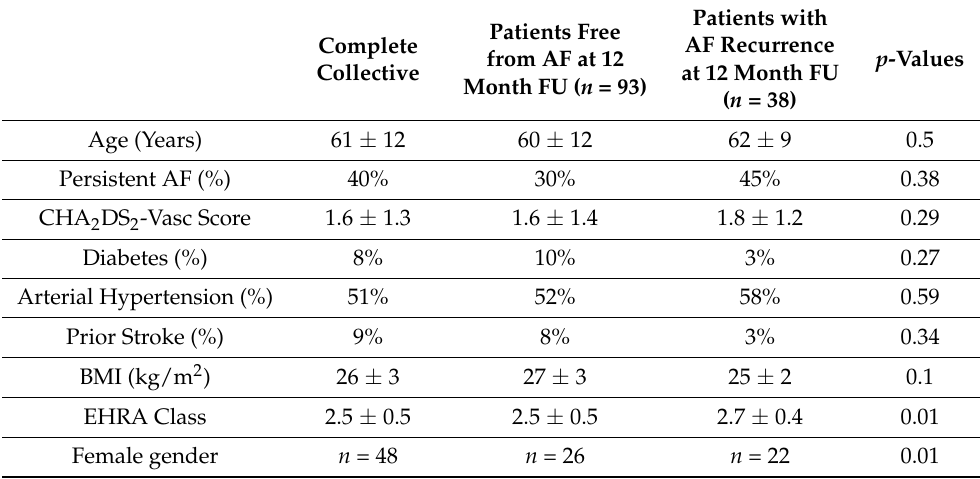
Table 1. Baseline characteristics of patient